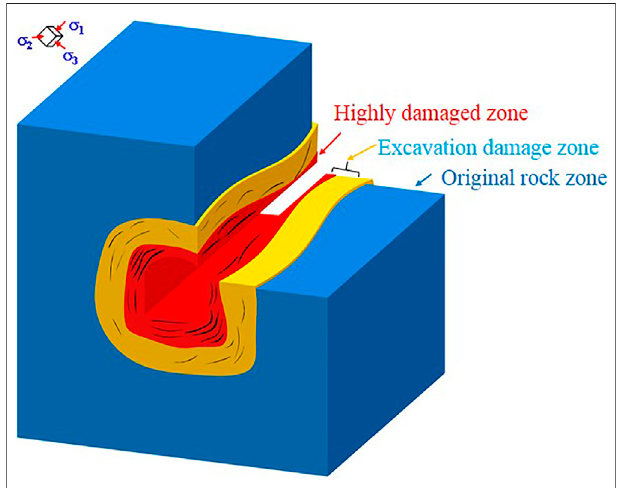
FIGURE 1 | Two major categories in surrounding rock.